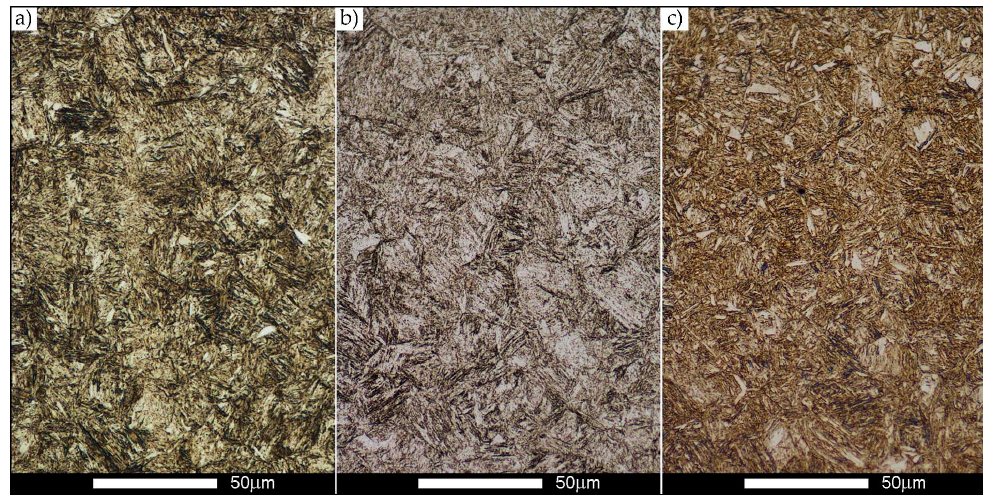
Figure 9. Microstructure of base material Hardox Extreme: ( a ) condition before welding—structure of tempered martensite; ( b ) condition after welding—BM zone in Figure 5, characteristic structure of tempered sorbite; ( c ) condition after heat treatment—BM zone in Figure 6, structure of hardening martensite. Light microscopy, etched with 2% HNO 3 .